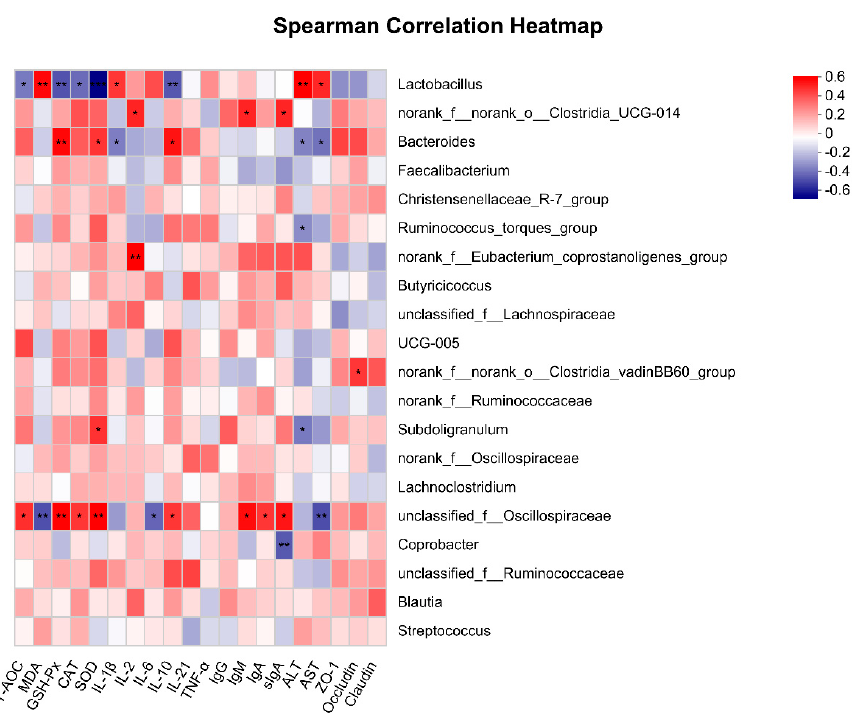
Antioxidants 2023 , 12 , x FOR PEER REVIEW 18 of 27